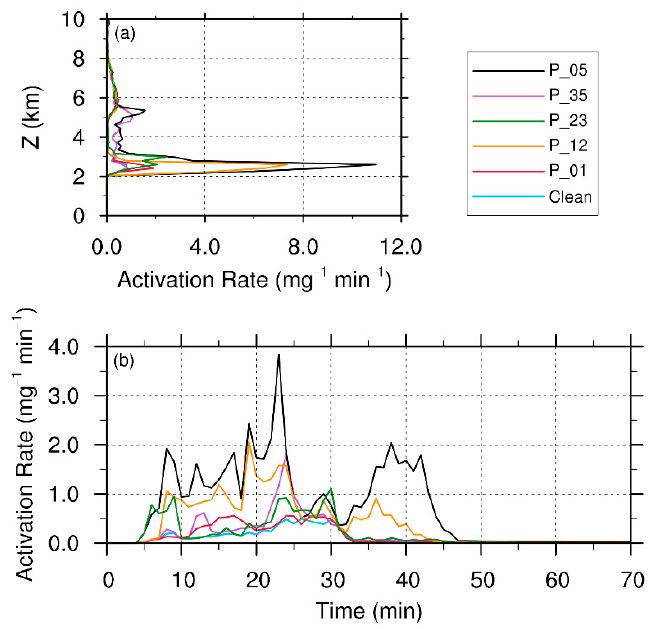
Figure 4. The ( a ) vertical profiles and ( b ) time series of CCN activation rate in all the simulations. The average region is a column with the center at the domain center, 10 km radius, and 24 km height. The vertical distribution is time-averaged from 0 to 70 min.